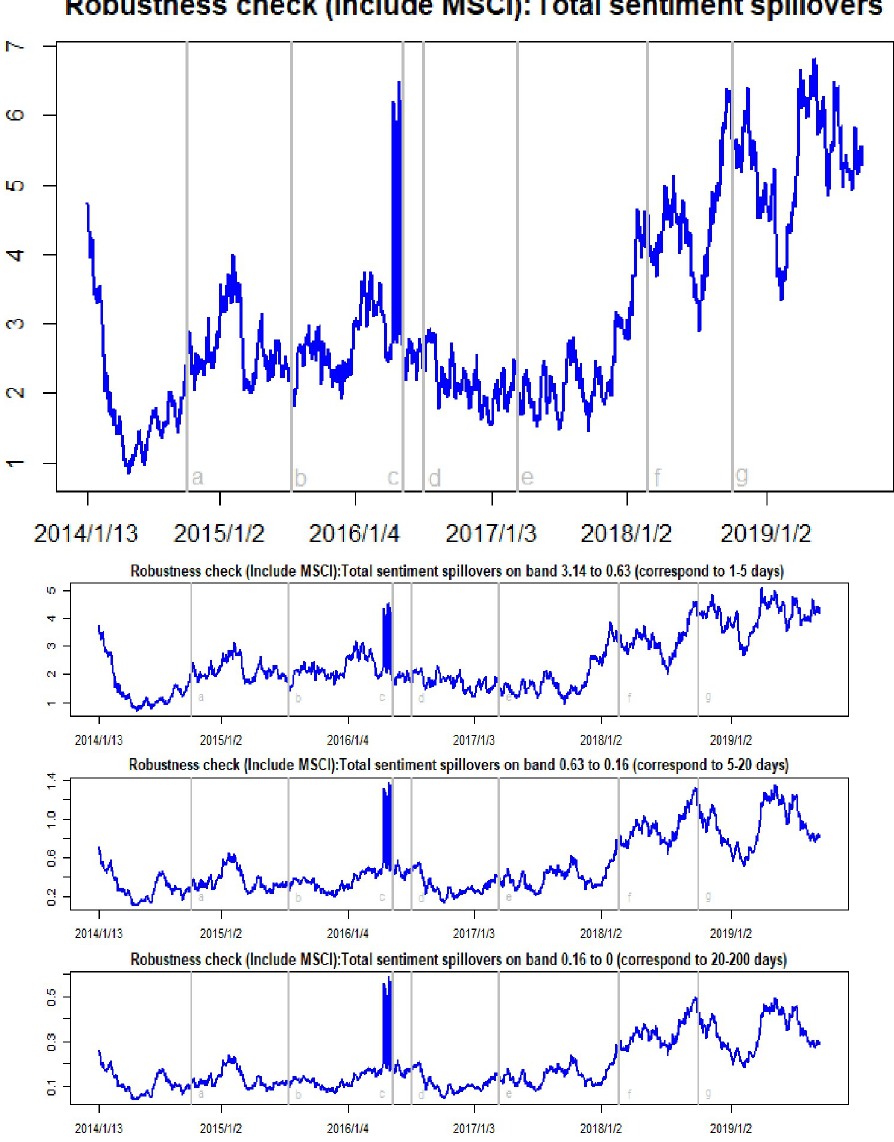
Fig 9. Robustness check (Include MSCI): Time-frequency dynamics of total sentiment spillovers. a, b, c, d, e, f, g respectively represent the seven events: the WTI oil price collapsed in October 2014, the black swan event in gold market occurred in July 2015, the sharp rise of bitcoin prices in May 2016, the Brexit event in July 2016, the expectations of a Federal Reserve rate hike in March 2017, the price of Bitcoin and gold fluctuating fall at the beginning of 2018, and the WTI oil price declines in August